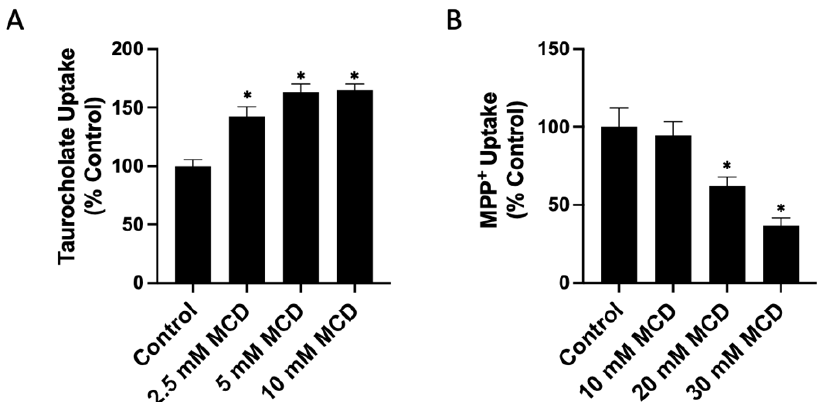
Figure 2. Transporter-mediated substrate uptake as a function of decreased free cholesterol content. Uptake of ( A ) (100 µ M) [ 3 H]-taurocholate for NTCP- and ( B ) (16.7 nM) [ 3 H]-MPP + for OCT1-expressing HEK293 cells was measured for 30 s at 37 ◦ C, 30 min after treatment with increasing methyl- β -cyclodextrin (MCD) concentrations. Net uptake was determined as in Figure 1, and results were calculated as percent of control and reported as the mean ± SD of three independent experiments; asterisks indicate a p < 0.05.